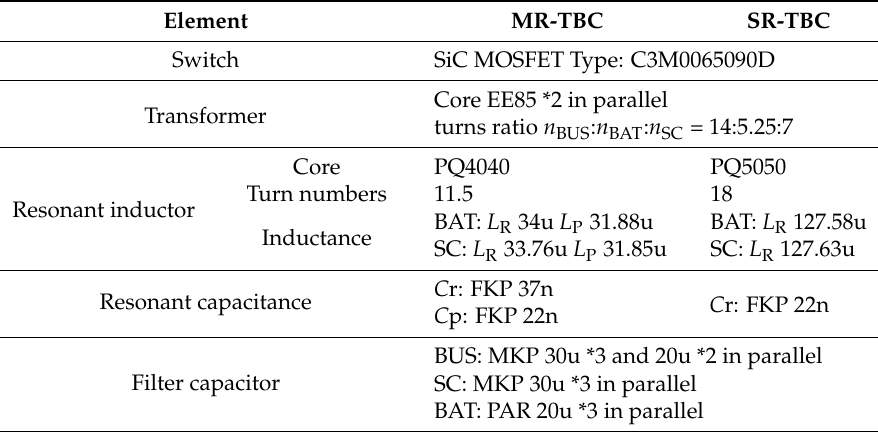
Table 1. Parameters of the proposed MR-TBC and SR-TBC.